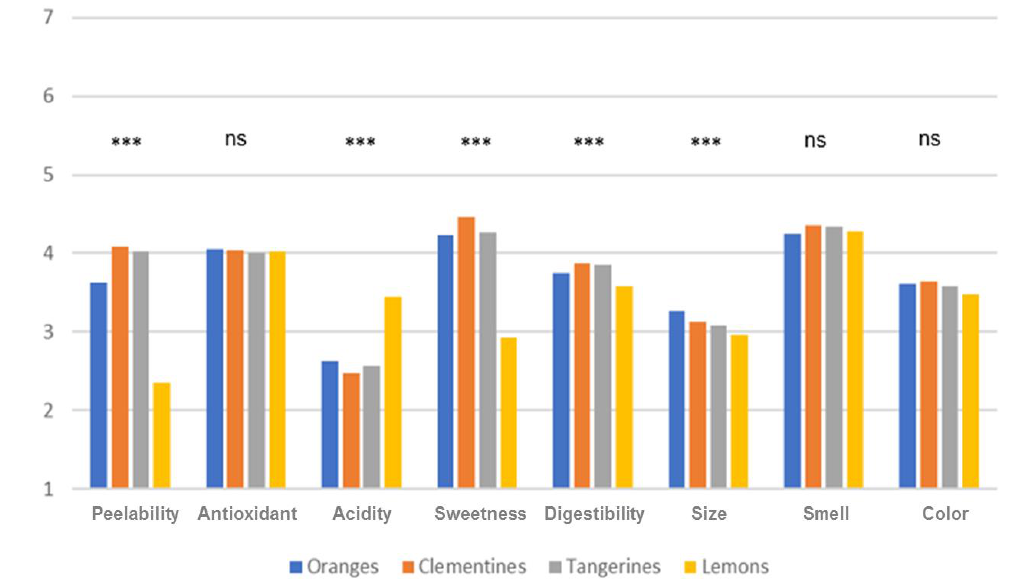
Figure 2. Importance of specific citrus fruit attributes. Scale from 1 = not at all important when purchasing the product, to 7 = extremely important. ***: means are statistically different according to t -test pairwise comparisons, at least at the 5% level; ns: means are not statistically significant according to the t -test pairwise comparison.